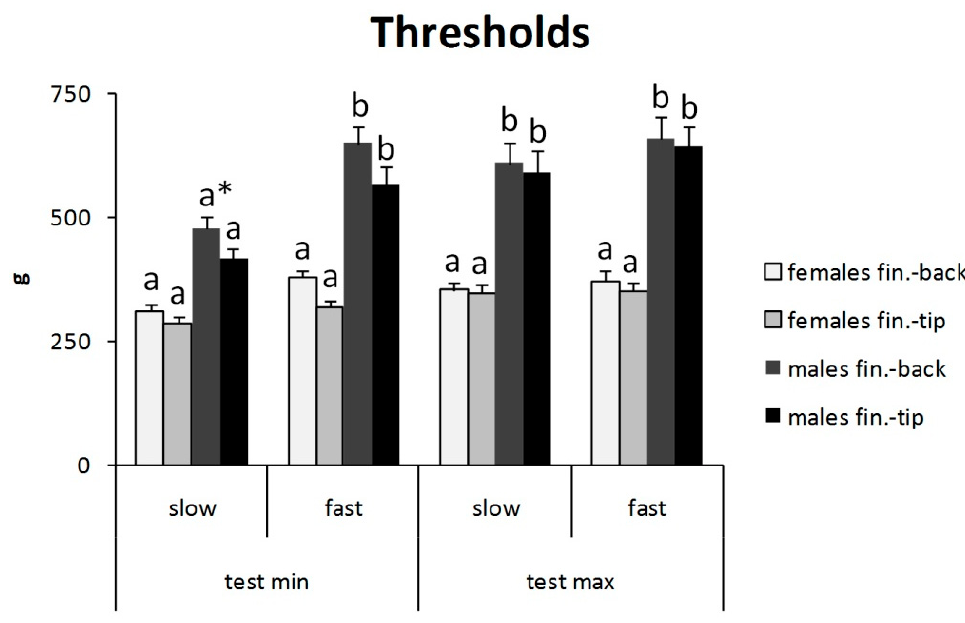
Figure 7. Algometric threshold differencesfor site of stimulation. Fin., finger. * p < 0.01.